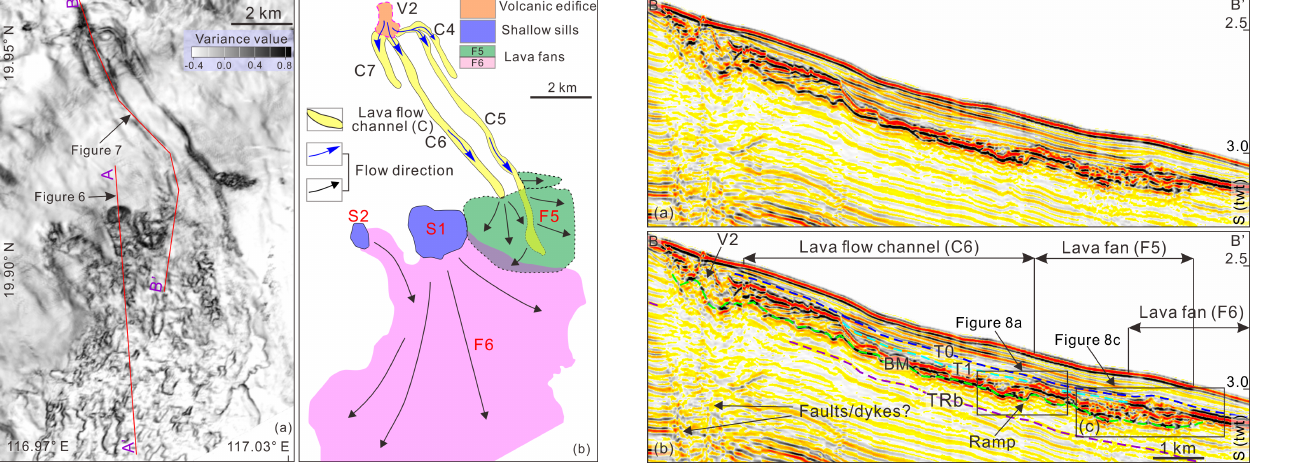
Figure 7. (a) The seismic profile and (b) its interpretation cross-cut V2 and along the lava flow channel (C6) and lava fans (F5 and F6). V2 has a sharp boundary to the upslope. Lava fan 6 (F6) is directly overlying lava fan 5 (F5). BM – base of volcano–lava flow; see the location of seismic profile B–B’ in Fig.